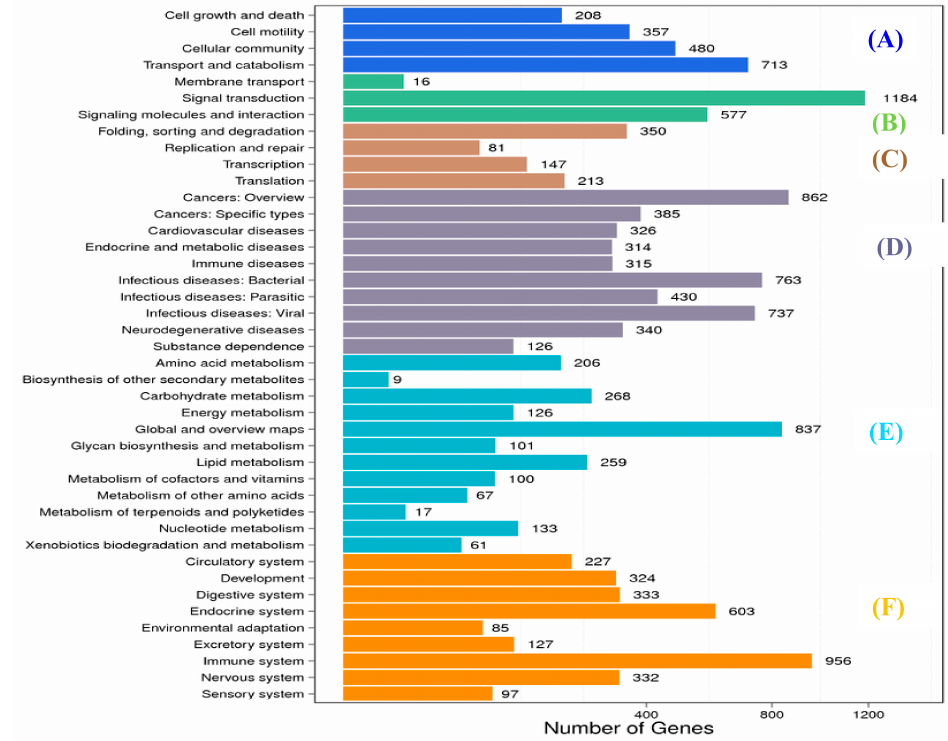
Figure 3. KEGG (Kyoto Encyclopedia of Genes and Genomes) classifications of DEGs (differentially expressed genes) in spleen. ( A ) Cellular processes; ( B ) environmental information processing organismal systems; ( C ) genetic information processing metabolism; ( D ) human diseases; ( E ) metabolism and ( F ) organismal systems.